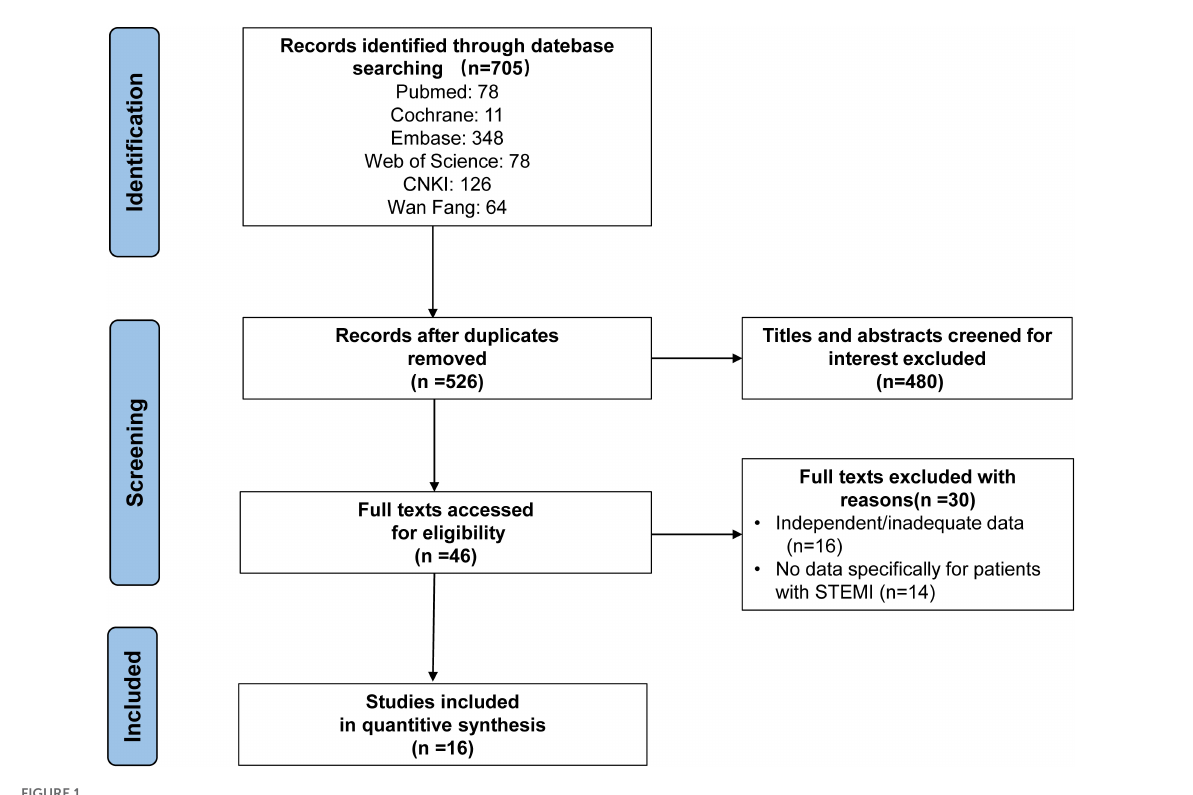
FIGURE1 Literature search